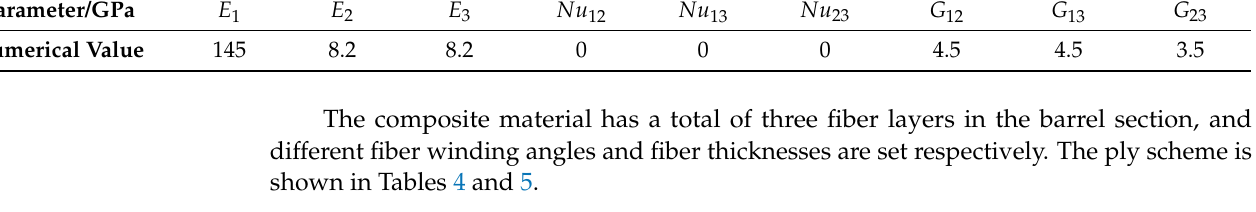
Table 4. Fiber layer ply angle design